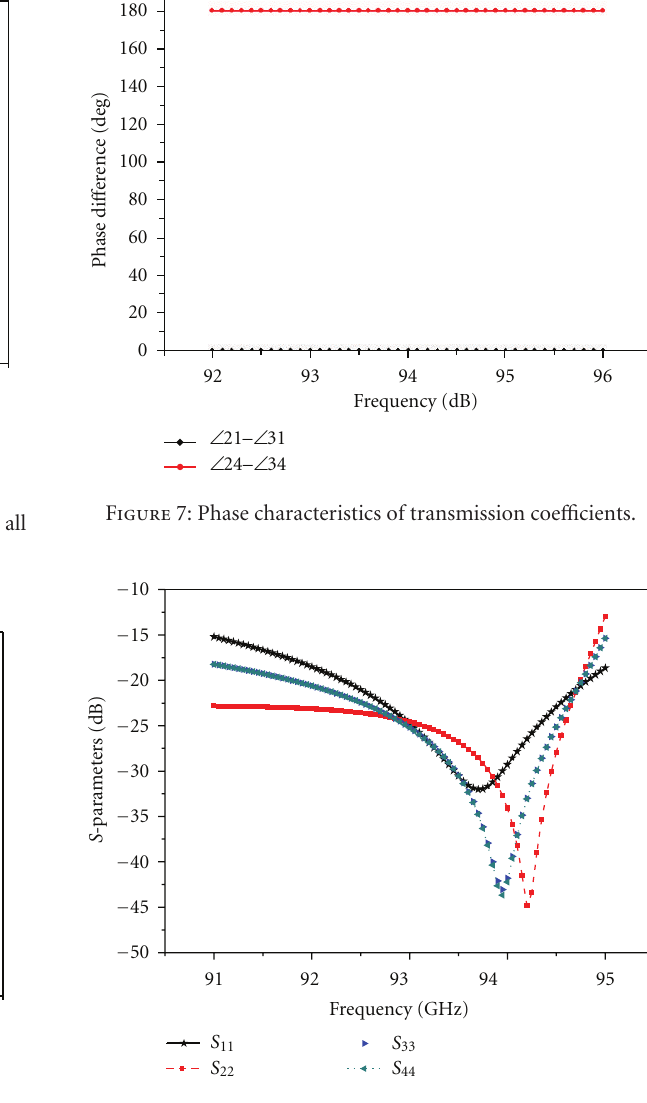
Figure 8: Fully compensated H-FMT S -parameters of all